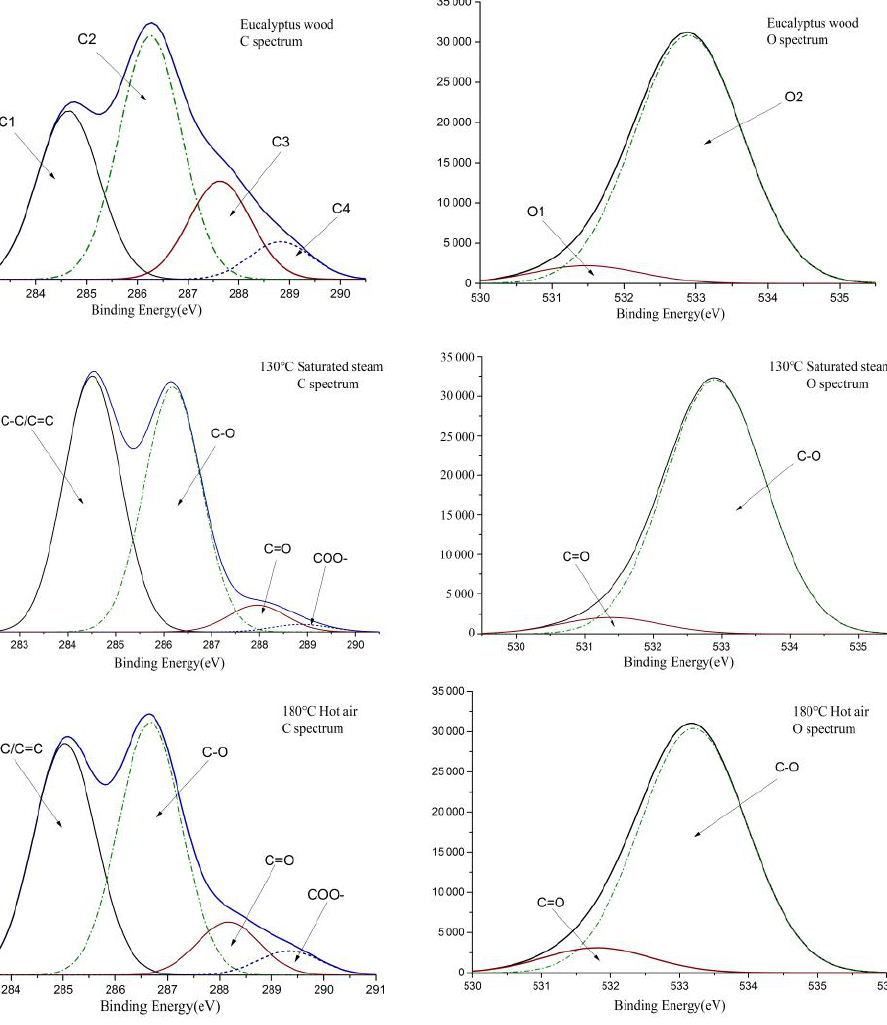
Figure 4. XPS spectra of Eucalyptus wood before and after thermal treatment.